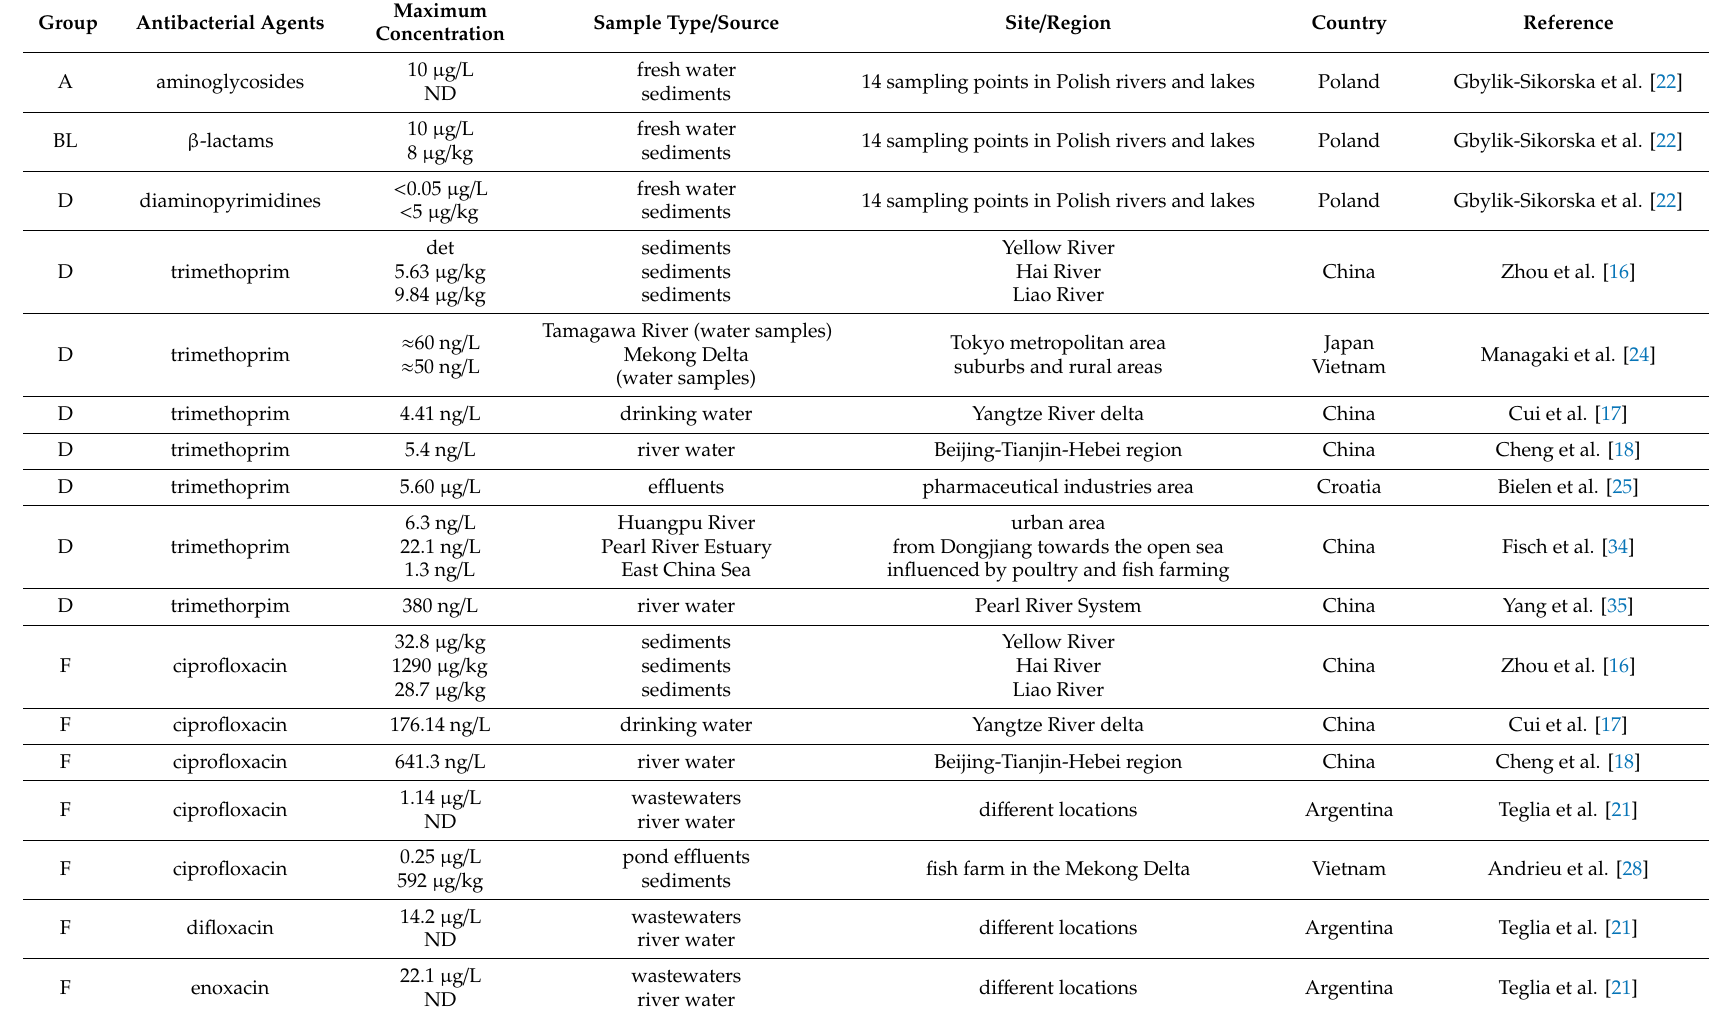
Table 1. The occurrence of antibacterials in the aquatic